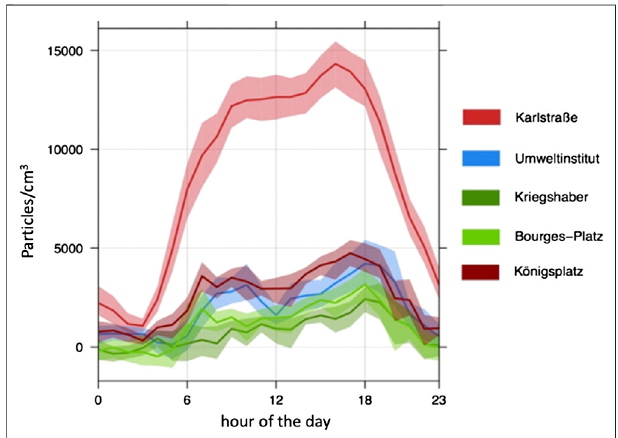
FIGURE 9 | Daily cycles of the additional local loads of the UFP number concentrations normalized to the urban background load [lines: mean values; shaded areas: fl uctuation range between 5th and 95th